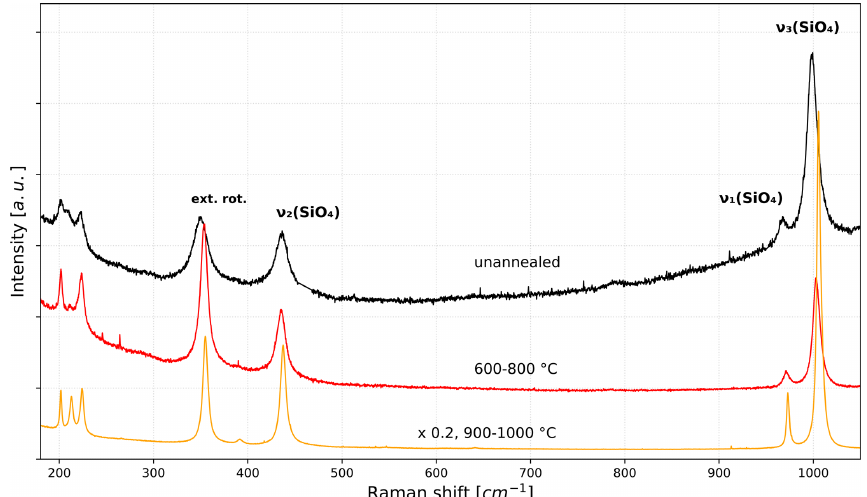
Figure 1. Raman spectrum of an unannealed, radiation-damaged zircon (black, damage density ≈ 80 × 10 16 α /g, calculated after Váczi and Nasdala, 2017) compared with the spectra after its cumulative annealing for 1h at 600, 1h at 700, and 1h at 800 ◦ C (red), and additional heating for two 1h steps at 900 and 1000 ◦ C (orange). The intensities of the latter two spectra are reduced by a factor of 5 for comparison.